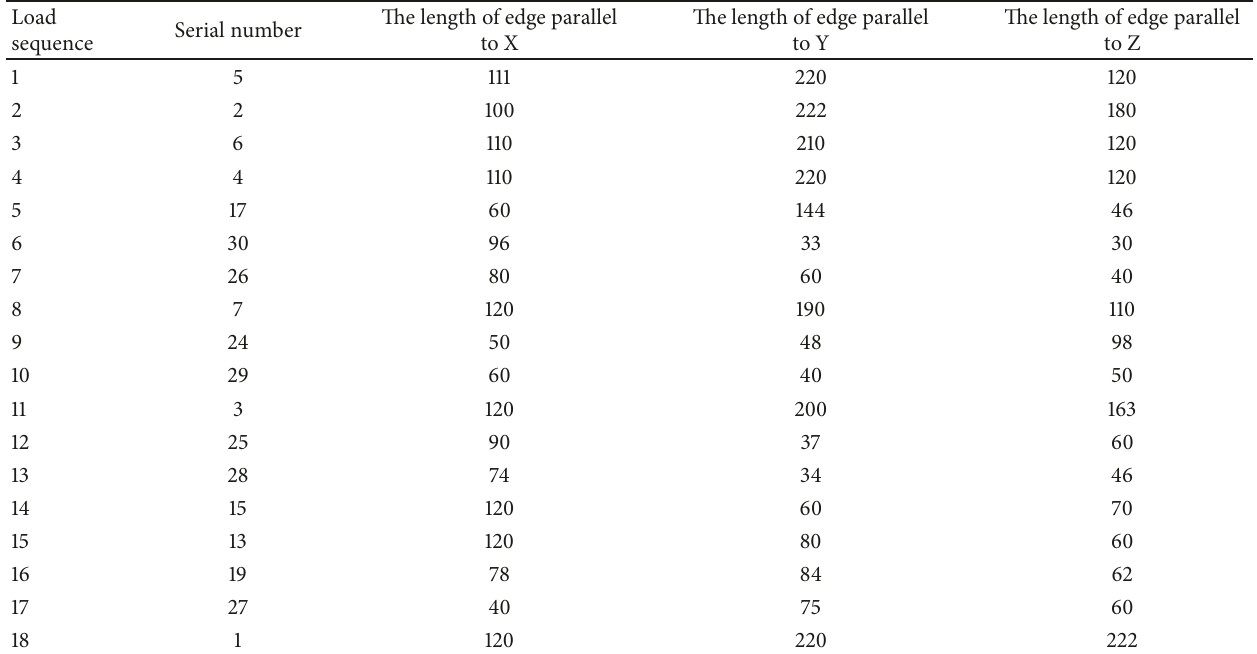
Table 7: Test result of strongly heterogeneous problem.